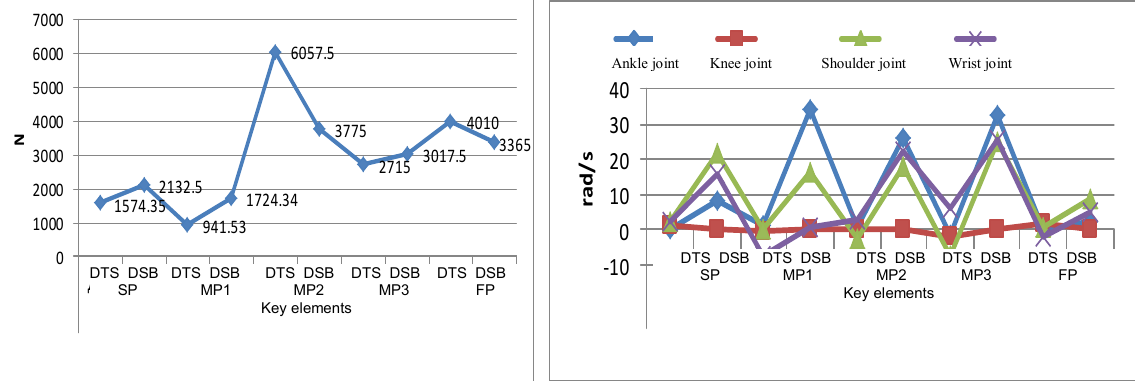
Fig. 2.Indicators of GMC resultant force, angle velocity of female gymnastsin key elements of DTS and DSB acrobatic jumps in FX routine (n =